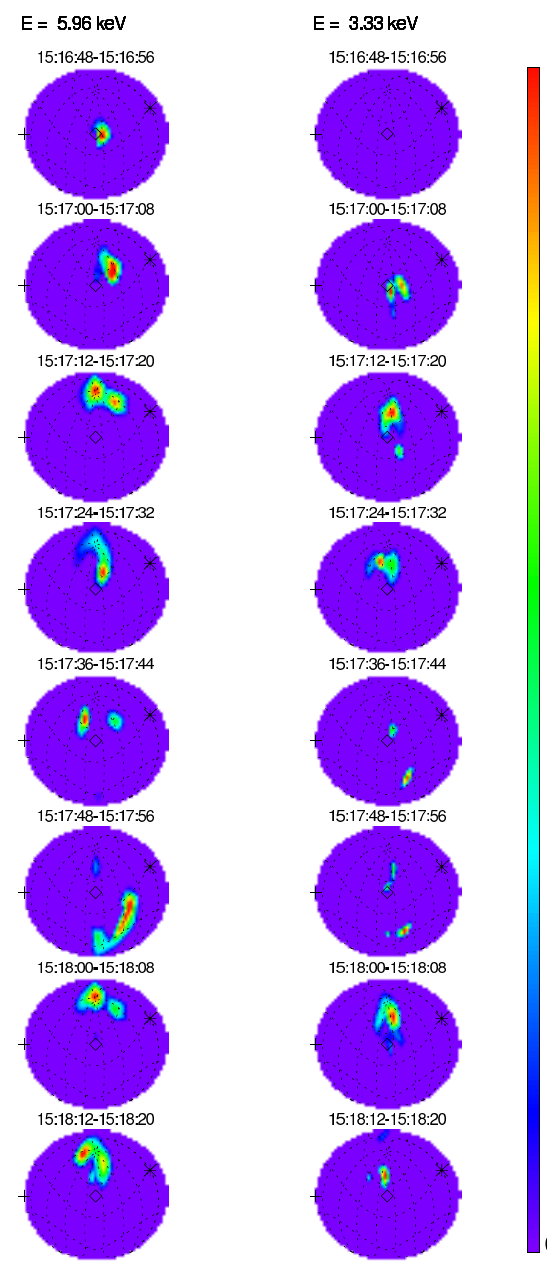
Fig. 2. Energy slices from 8-s 3-D measurements of ion distributions from CIS/CODIF. The ∼ 6keV and ∼ 3.4keVpanels each show 4 π sr of solid angle for a detector energy channel. The diamond at the center represents the anti-field aligned direction, which is directed out of the page, and the solar wind direction is indicated by the “*” symbol. Each separately normalized panel represents phase space densities in the solar wind frame of